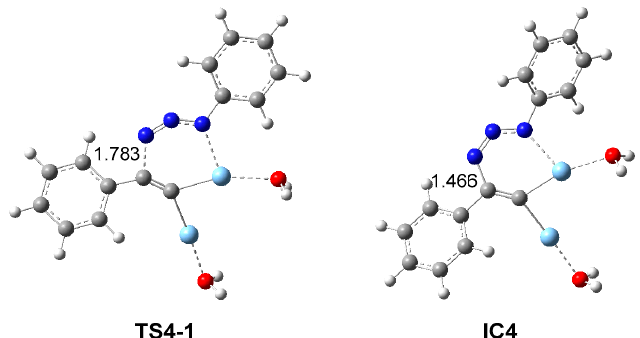
Figure 13. Optimized geometries (in water) of TS4-1 and IC4 associated to the dinuclear AgAAC reaction of Ac2 and Ac4 with 6 . Distances are given in Å.